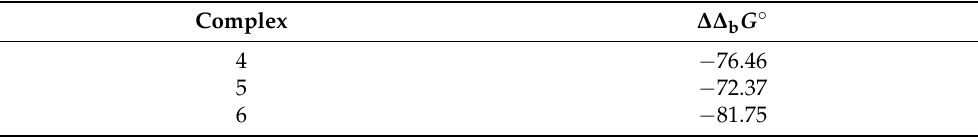
Table 1. Calculated differences of standard Gibbs energies of binding ∆∆ b G ◦ between square planar [Ni(L)(py)] and octahedral ([Ni(L)(py) 3 ] complexes. Complex ∆∆ b G ◦ 4 − 76.46 5 − 72.37 6 −